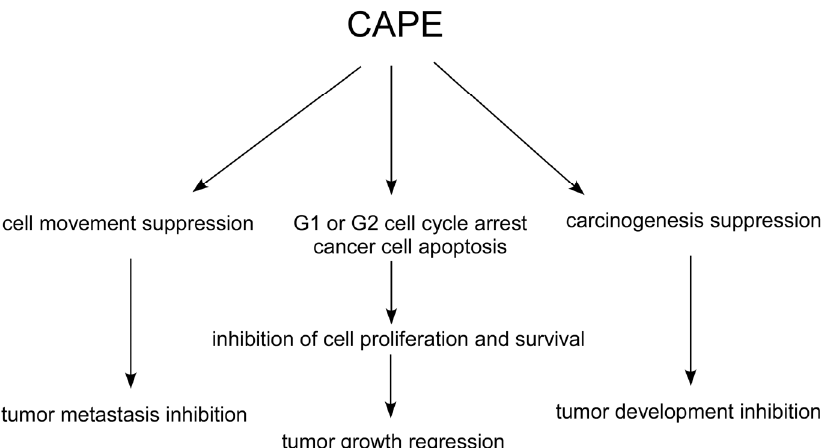
Figure 2. Effects of CAPE treatment on human cancer cells. Treating human cancer cells with CAPE causes suppression of carcinogenesis, cell cycle progression, and cell movement. CAPE also stimulates apoptosis in cancer cells. These changes then give rise to the inhibition of development, growth, and metastasis of